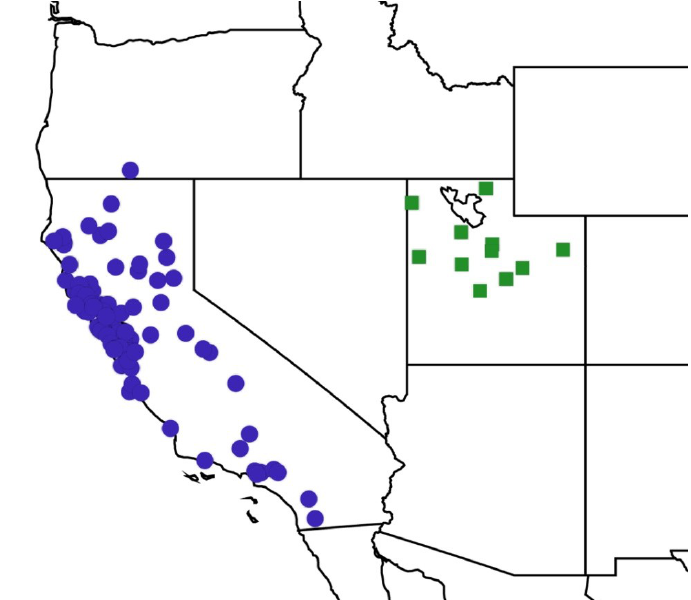
Figure 39. Distribution of Platypedia similis (blue circles) and P. affinis (green squares).